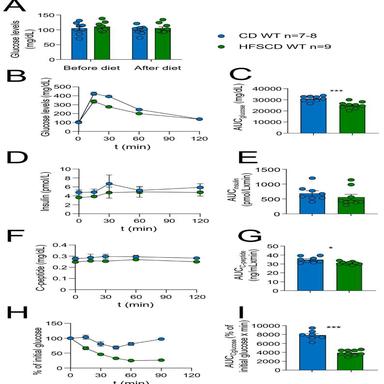
Metabolic characterization of WT mice placed 16 weeks on CD and HFSCD. (A) Plasmatic fasting glucose before and after the diet in WT mice fed both diets. Plasmatic (B) glucose, (D) insulin and (F) C-peptide levels at the different time points during the GTT. These were used to calculate the AUCglucose (C), AUCinsulin (E) and AUCC-peptide (G), in CD- and HFSCD-fed WT mice. (H) Plasmatic glucose levels (in percentages relative to the initial glucose levels) during the ITT and the AUCglucose (I) parameters for